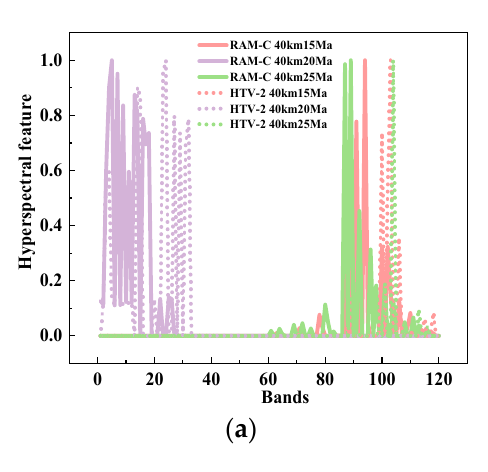
Figure 5. Extracted PCA features.